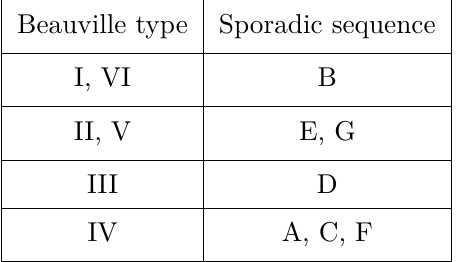
Table 3 . Correspondence between Beauville’s classification of elliptic curves with four singularities and the sporadic solutions of